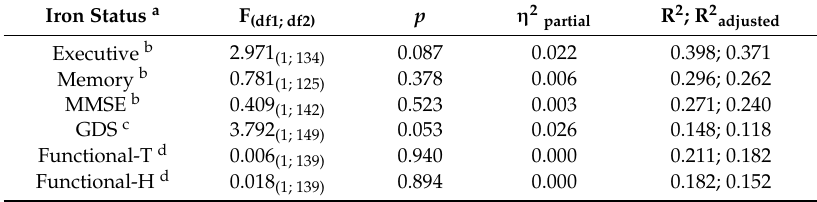
Table A3. ANCOVA for the test of di ff erences between iron su ffi ciency and deficiency groups.